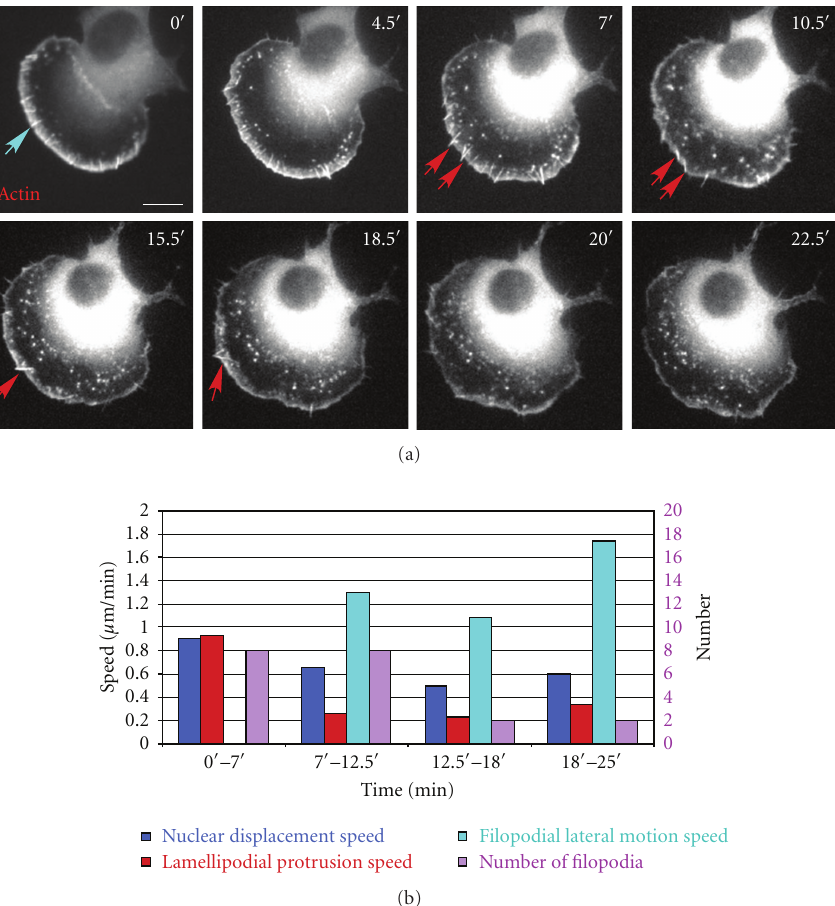
Figure 3: Filopodial behavior during continuous cell movement. (a) The formation and movement of filopodial structures was tracked in GFP-T-plastin/mCherry-actin coexpressing cells migrating at di ff erent speeds (0.98, 0.71, 0.56, and 0.66 μ m/min during 0 (cid:3) –7 (cid:3) , 7 (cid:3) –12 . 5 (cid:3) , 12 . 5 (cid:3) –18 (cid:3) , and 18 (cid:3) –25 (cid:3) , resp.). Only the actin probe is shown. When filopodia started projecting beyond the lamellipodium at 7 (cid:3) , the cell did not start retraction, but instead continued to move forward. Turquoise arrow indicates a stationary filopodium, red arrows represent lateral filopodia. The entire movie can be found in Supplementary Data, Movie 2. (b) Cell protrusion, speed and filopodial behavior. Light blue, red, turquoise and pink column show the speed of nuclear displacement, lamellipodial protrusion, filopodial lateral motion, and the number of stationary and lateral filopodia, respectively. The speed of filopodial lateral motion was measured by the displacement of the distal end of lateral filopodia over time. Scale Bar 10 μ